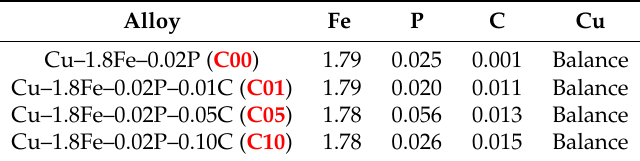
Table 1. The measured compositions of the alloys under investigation